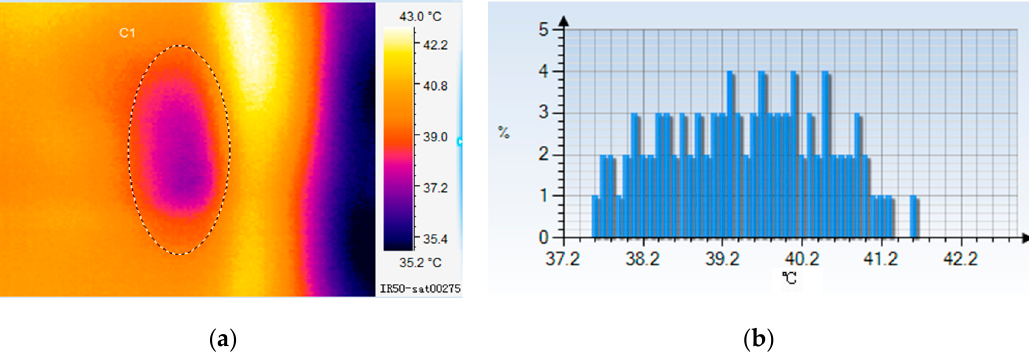
Figure 12. Infrared imaging and temperature distribution after irrigation at 12:50 p.m., ( a ) Infrared imaging ( b ) Temperature distribution